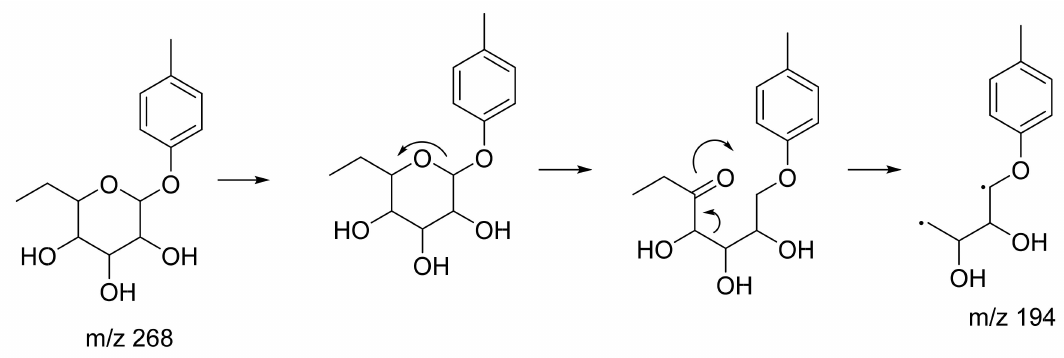
Figure 9. Proposed fragmentation pathway for (2R,4S,5S,6R)-2-ethyl-6-(4-methylphenoxy)oxane-3,4,5-triol. Surprisingly, when annotating the LC-MS/MS analysis data (Figure 2) in MN, at RT 10.84 ( m / z 331) and RT 11.06 ( m / z 293) two high peaks were thought to be attributed to unknown compounds. However, when viewed from the MN, the mass shows an overlap with a blank node (circled in red in Figure 3), therefore the peaks were deduced to be blanks and not compounds from the leaf